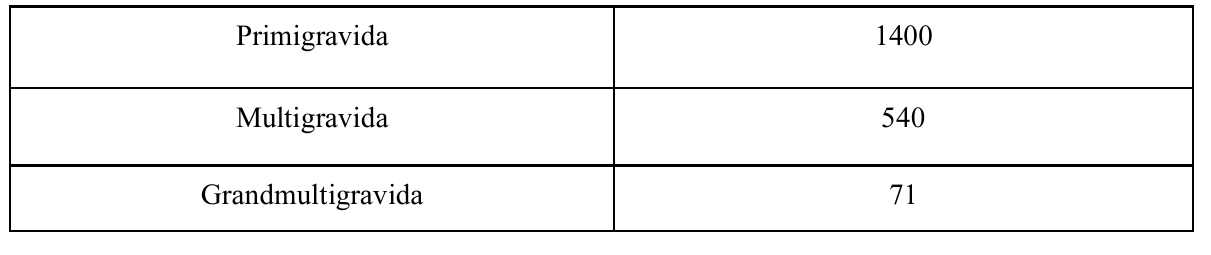
Table 3: Gravidity Status of the